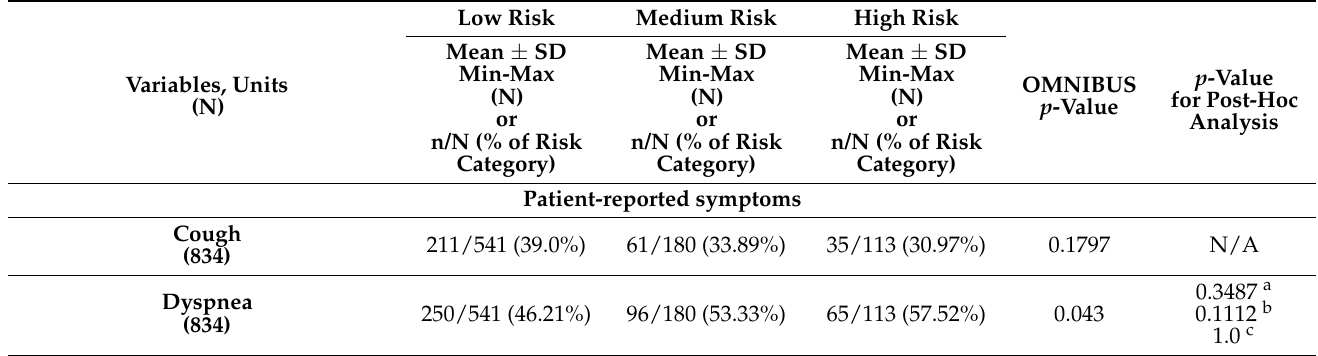
Table 3. Patient-reported symptoms, vital signs, and abnormalities measured during physical examination at hospital admission in the studied cohort after GRAM risk